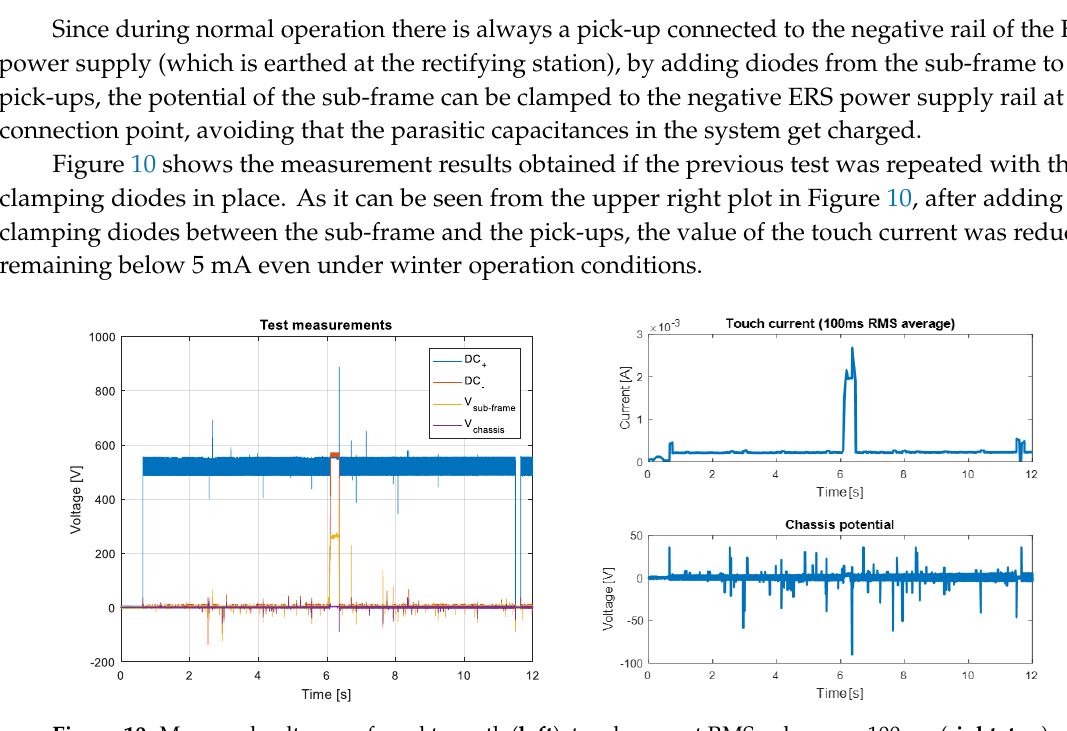
Figure 9. Measured voltages referred to earth ( left ), touch current RMS value over 100 ms ( right , top ), and chassis potential ( right , bottom ) under a loss of connection to the negative rail in winter conditions.